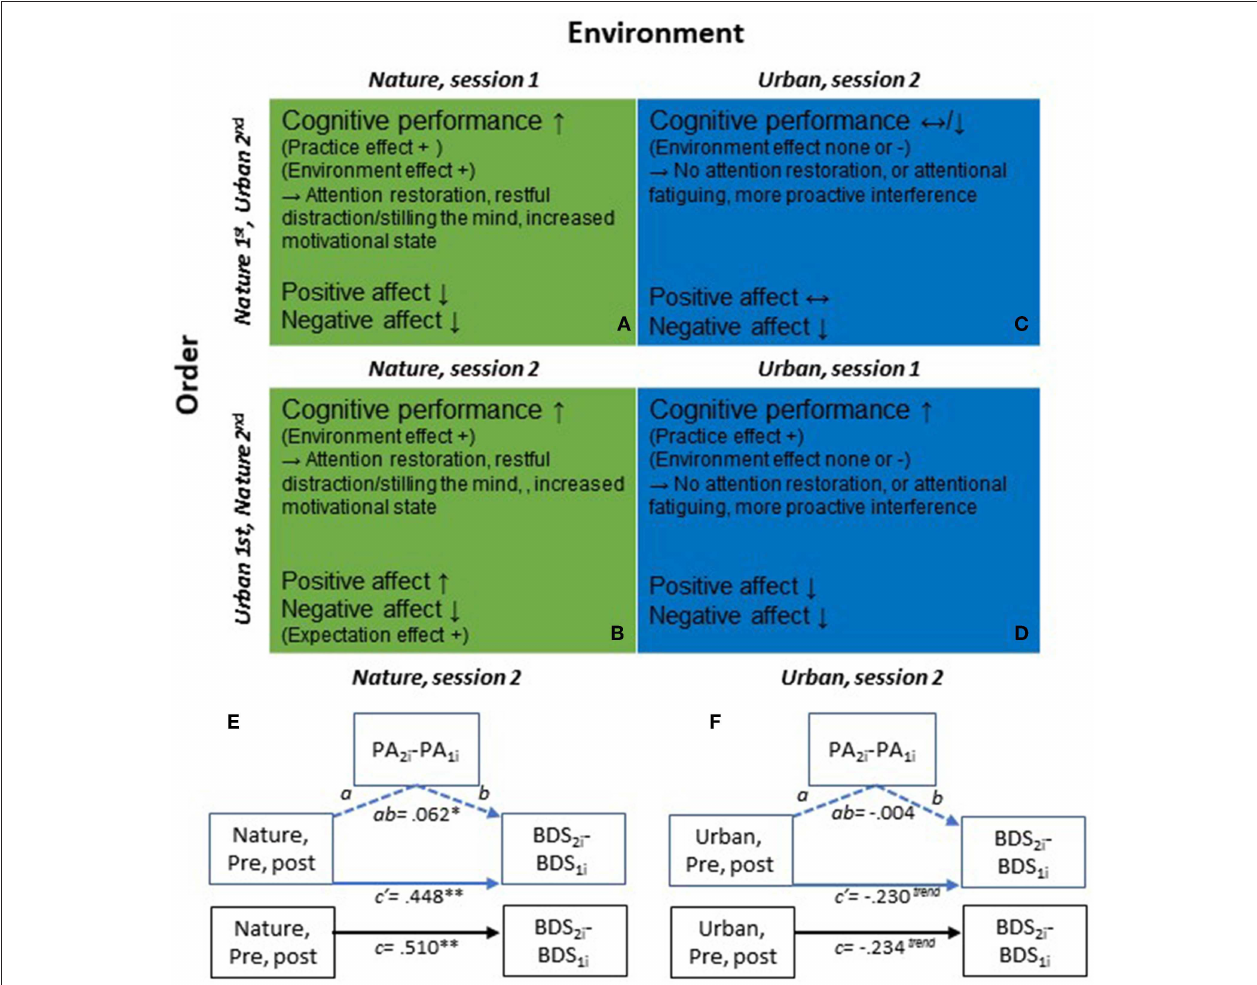
Diagram 1 | (A–D) Illustration of general effects and potential mechanisms of action on cognitive performance and affect from pre- to post nature vs. urban environment interactions, and the order of participation in the environment conditions. (A) Nature environment interaction, Nature condition is tested in session 1; (B) Nature environment interaction, Nature condition is tested in session 2; (C) Urban environment interaction, Urban condition is tested in session 2; (D) Urban environment interaction, Urban condition is tested in session 1. Depending on the order in which individuals participate in the nature and urban conditions, the changes observed on cognitive performance and affect also differ. In first test sessions (A,D) , there are clear practice effects on cognitive performance in addition to the effects that are caused by the environment condition per se . Second test sessions (B,C) are instead devoid of the initial performance improvement due to practice, and the cognitive performance improvements observed constitute more clean effects of the environment conditions. Thus, the second sessions provide a better evaluation of the effects of the environment conditions per se on cognitive performance. Changes in affect also differ depending on the order of environment conditions. That is, positive affect increased after nature interactions performed in the second but not first sessions, which could be due to different expectations on the second session, depending on the experience (environment condition) in the prior, first session. That is, if the urban condition was done first, the expectations on the second condition may be low and the actual experience after the environment interaction in session 2 may have exceeded expectations. (E,F) Mediational path analyses of total, direct & indirect effects on BDS performance, via positive affect (PA), following nature vs. urban environment interactions, in 2nd test sessions. (E) Nature condition, 2nd test sessions: Total effect, c: 0.510 ( SE: 0.154, t = 3.320, df = 194, 95% CI: 0.207, 0.813 ); Direct effect, c ′ : 0.448 ( SE: 0.155, t = 2.885, df = 192, 95% CI: 0.142, 0.755 ); Indirect effect, ab: 0.062 ( SE: 0.038, 95% CI: 0.001, 0.145 ). (F) Urban condition, 2nd test sessions: Total effect, c : − 0.234 (